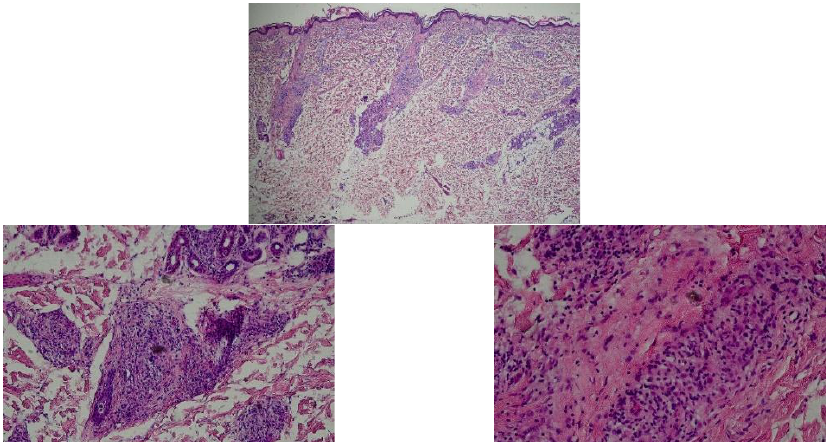
Figure 1. Skin biopsy revealed perivascular and periadnexal infiltration comprising histocytes and lymphocytes in the dermis, with the obvious involvement of nerves.